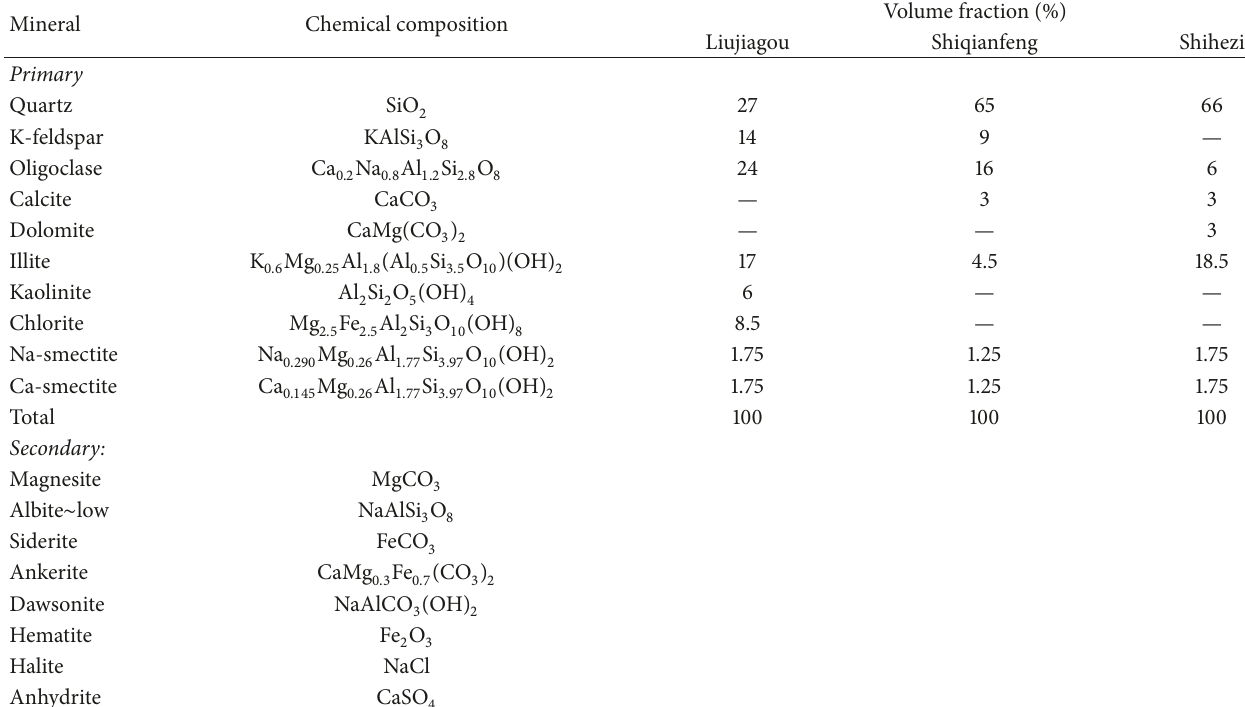
Table 2: Mineralogical compositions of the three formations, initial mineral volume fractions introduced in the model, and possible secondary mineral phases used in the simulations.